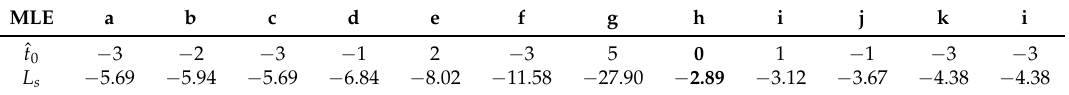
Table 1. The results of epidemic source localization in network. Where ˆ t 0 represents the initial time obtained from Equation (10) and L s is the target function value obtained from Equation (7). The node with the largest objective function value is the epidemic source in the network. For the three observers in the network ( I , e , g ) , use their infected time as the initial time